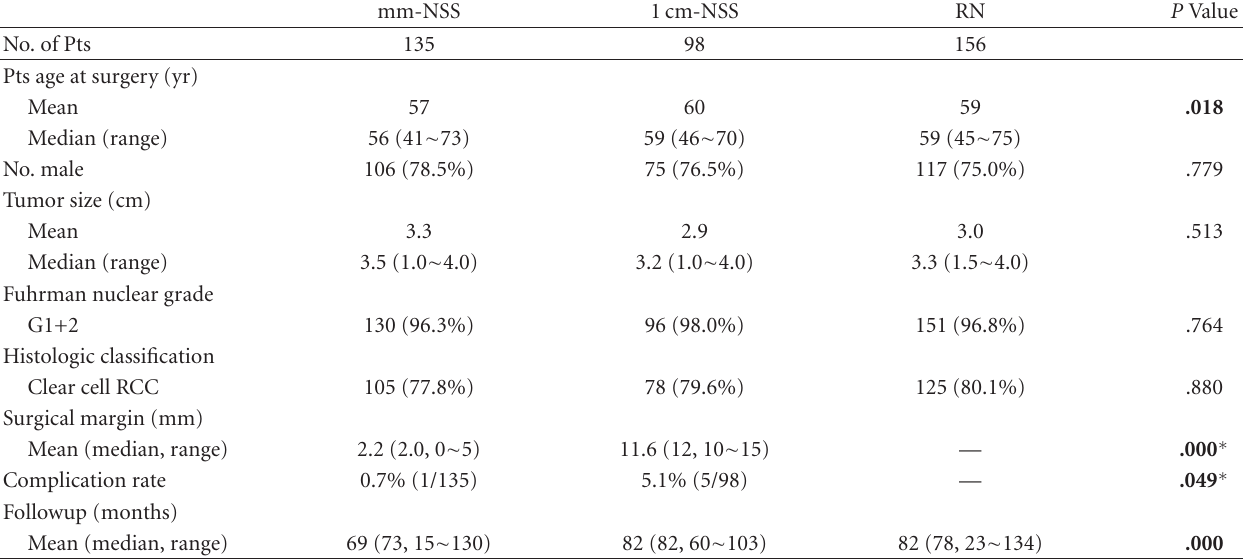
Table 1: Comparisons of the clinical and pathological